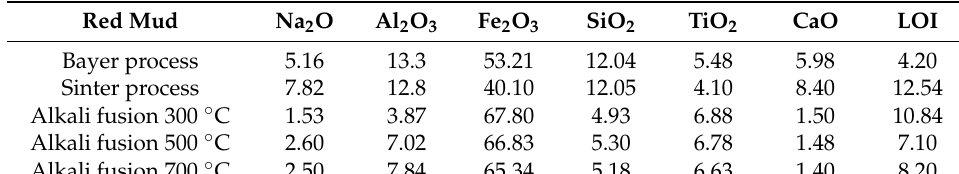
Table 2. The chemical compositions of red muds, wt. %.